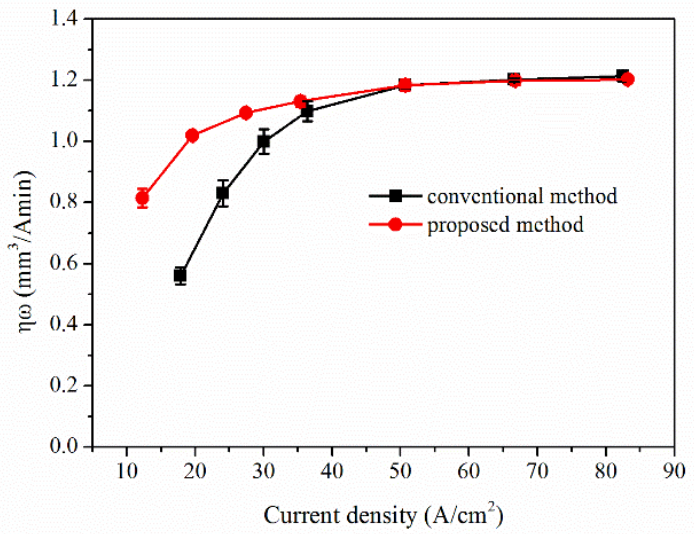
Figure 15. The current efficiency curves of 304SS.